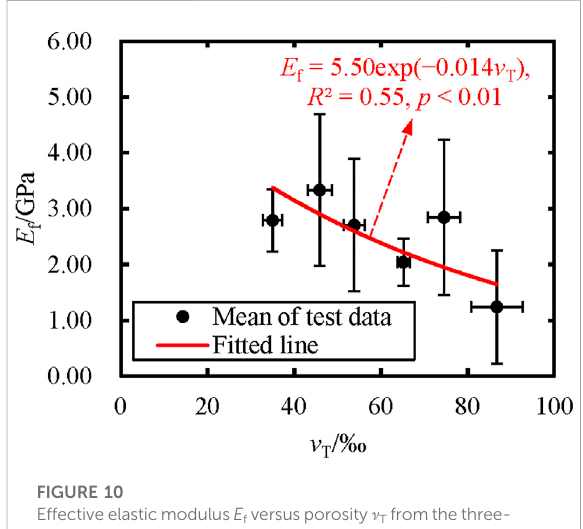
FIGURE 10 Effectiveelasticmodulus E f versusporosity ] T fromthethree- point bending tests. Solid circles represent the mean oftest results (the error bars represent the standard deviations). Also shown are the equation, coef fi cient of determination R 2 , and signi fi cance level p of the fi tted line.